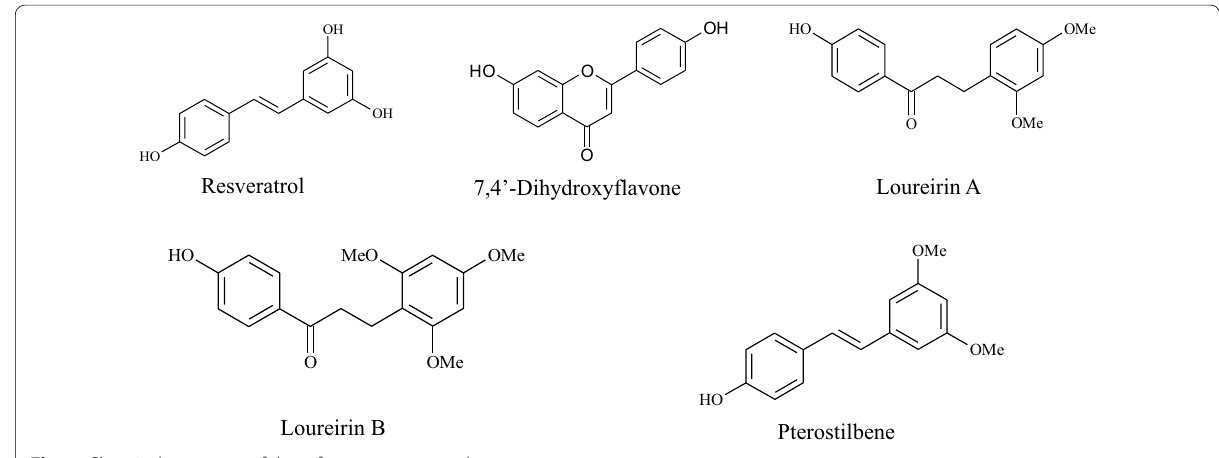
Fig. 1 Chemical structures of the reference